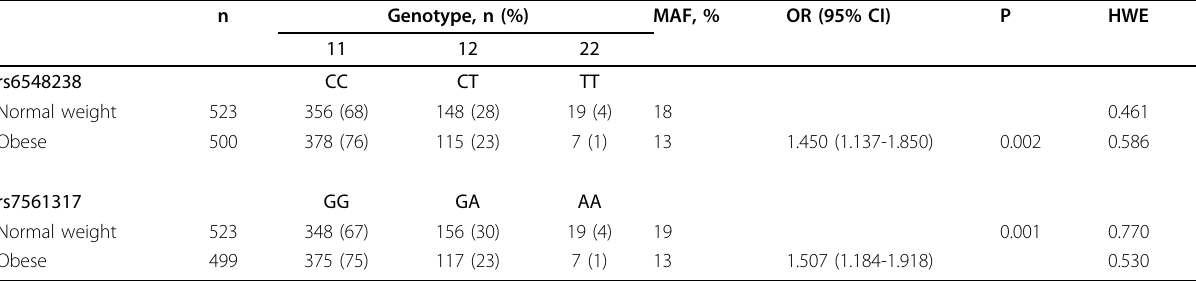
Table 1 Association study of TMEM18 rs6548238 and rs7561317 variants with obesity n Genotype, n (%) MAF, % OR (95% CI) P